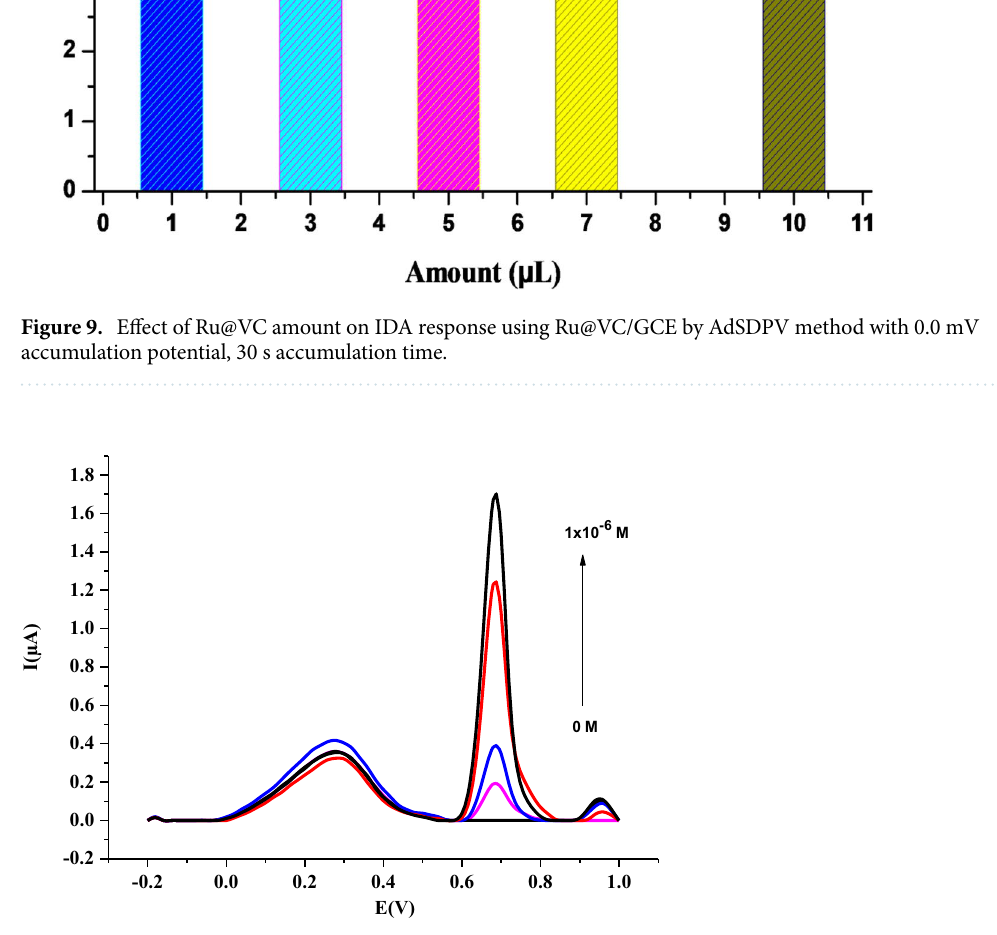
Figure 10. AdSDPV voltammograms at Ru@VC/GCE in phosphate buffer at pH 1.5 with 0.0 mV accumulation potential, 30 s accumulation